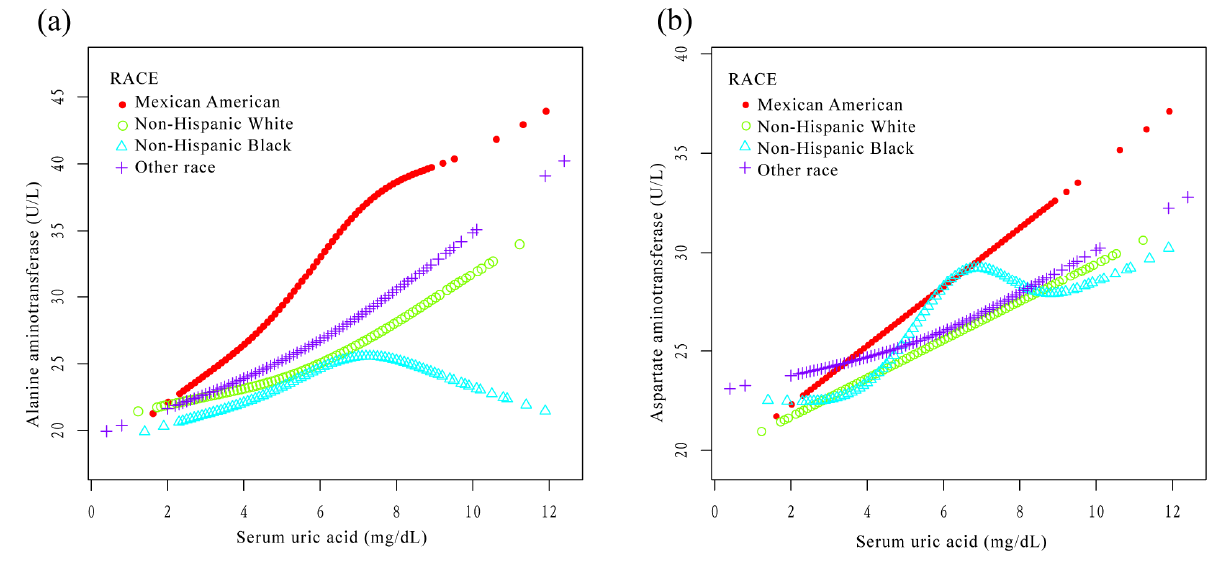
Figure 6. Relationship between serum uric acid and liver enzymes stratified by race. The lines represent fitted curves. ( a ) Relationship between serum uric acid and alanine aminotransferase stratified by race. ( b ) Relationship between serum uric acid and aspartate aminotransferase stratified by race.